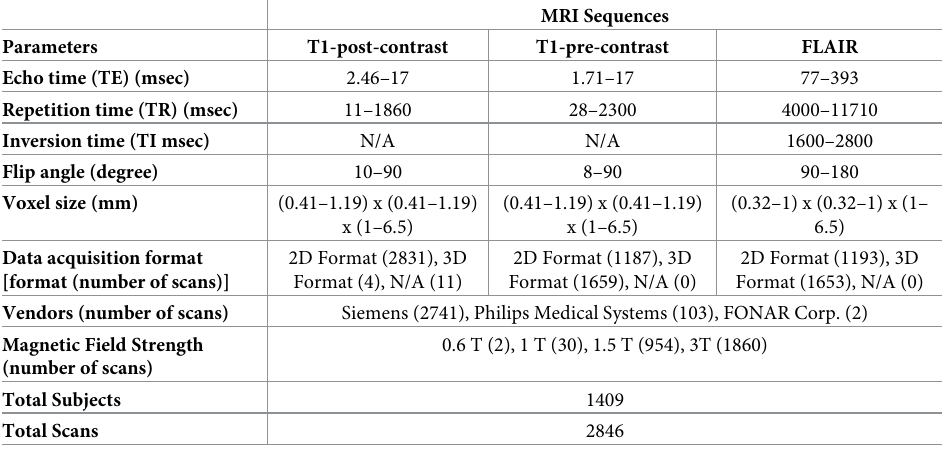
Table 2. Summary of MRI sequences parameters for lesion count dataset (Dataset B).